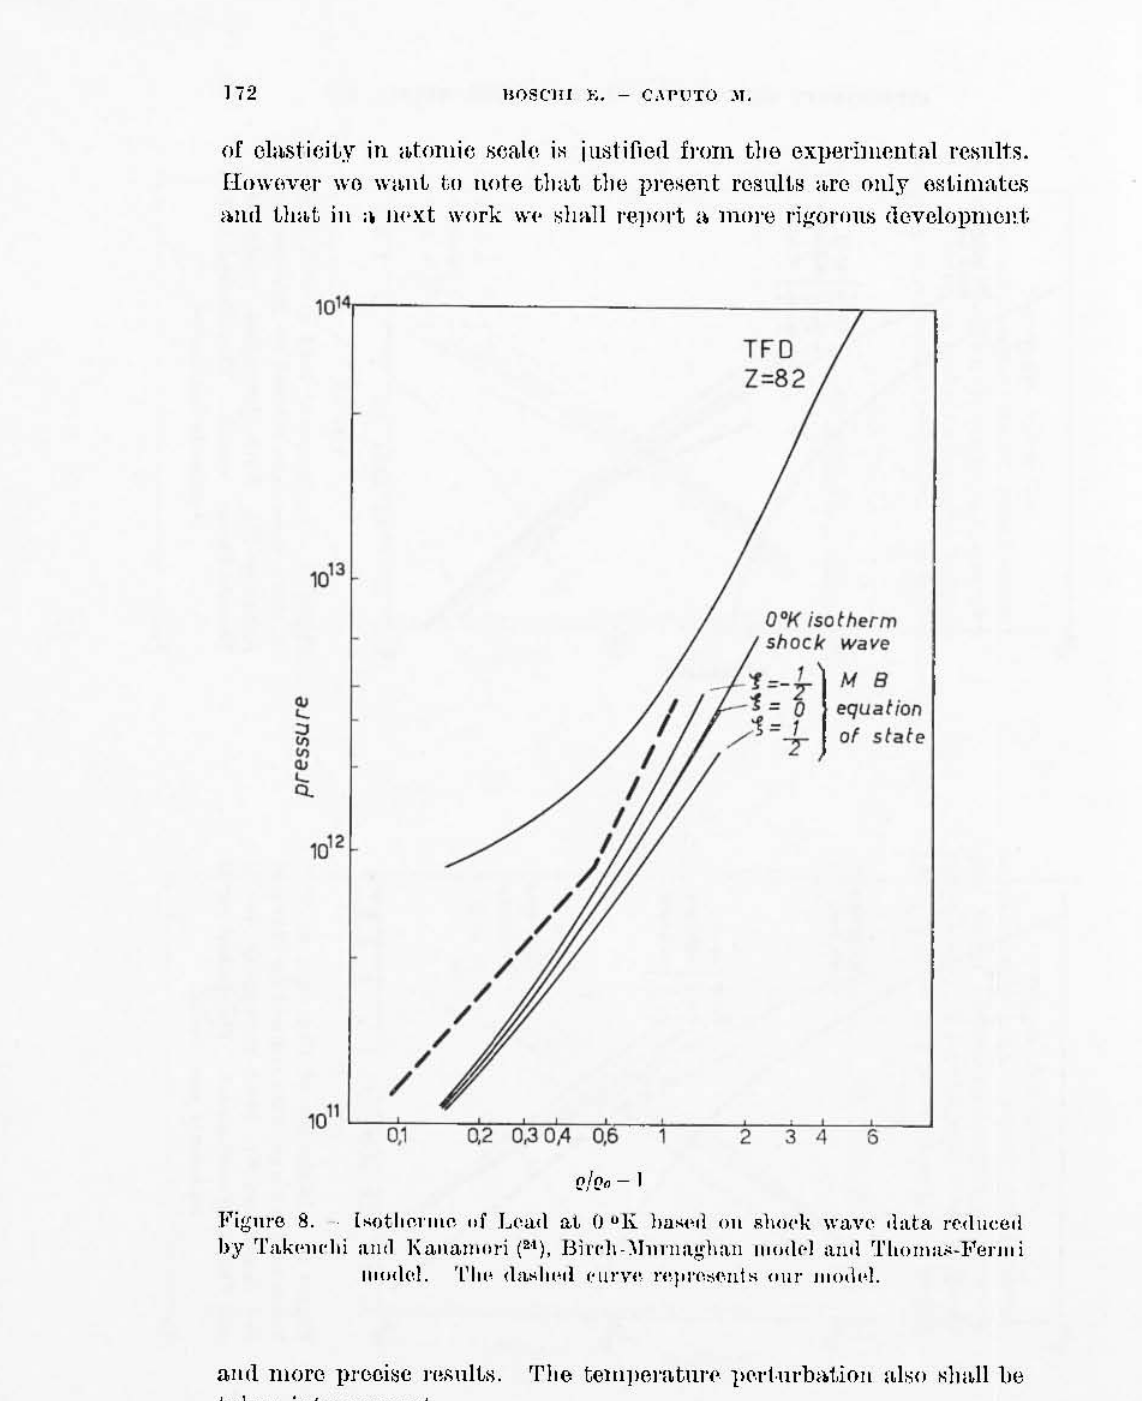
alld more pl"ooi~o ]"(lslllLs. tab'n illto